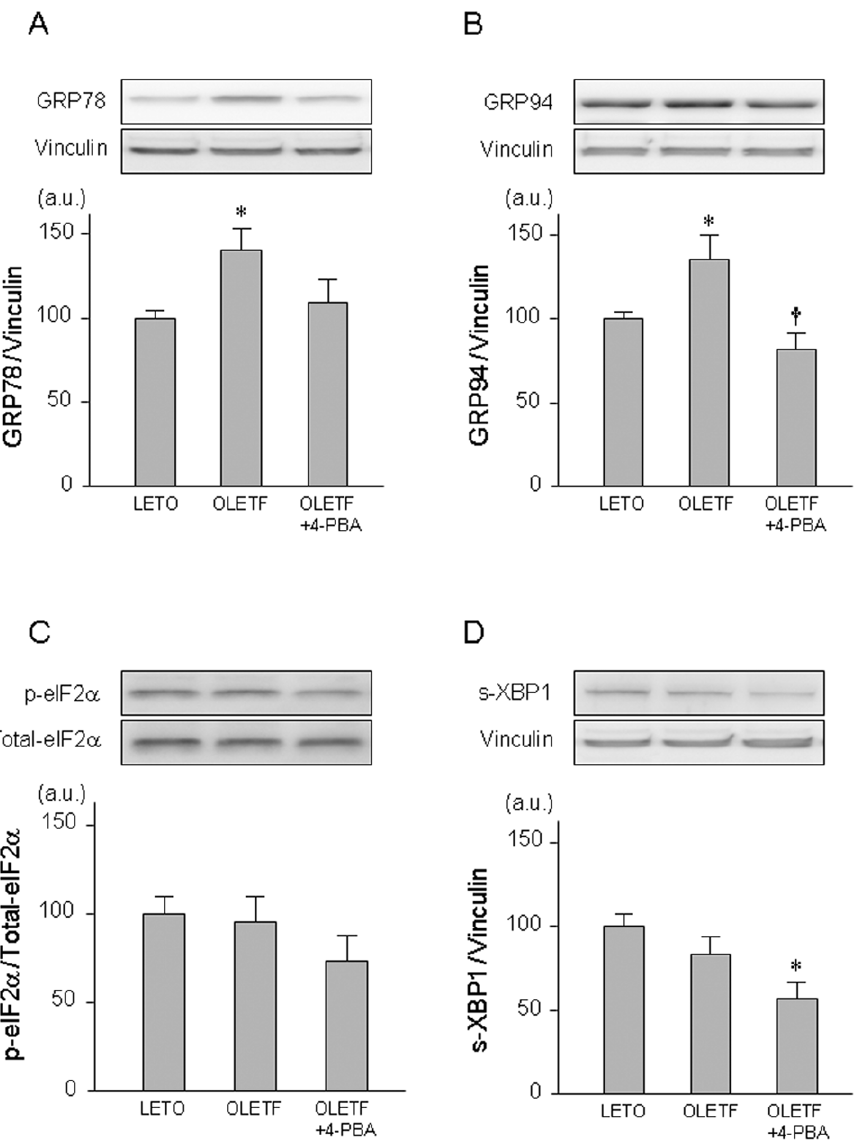
Figure 3. ER stress-related proteins in OLETF and LETO. Representative blots (upper panel) and summary of data (lower panel) from immnoblotting of GRP78 (A), GRP94 (B), phospho-eIF2 a (C), and spliced XBP1 (D) are shown. *p , 0.05 vs. LETO. { p , 0.05 vs. OLETF. n=6 , 8. GRP78= glucose-regulated protein 78; GRP94= glucose-regulated protein 94; eIF2 a = eukaryotic initiation factor 2 a ; XBP-1= X-box binding protein-1; 4- PBA=4-phenylbutyric acid.